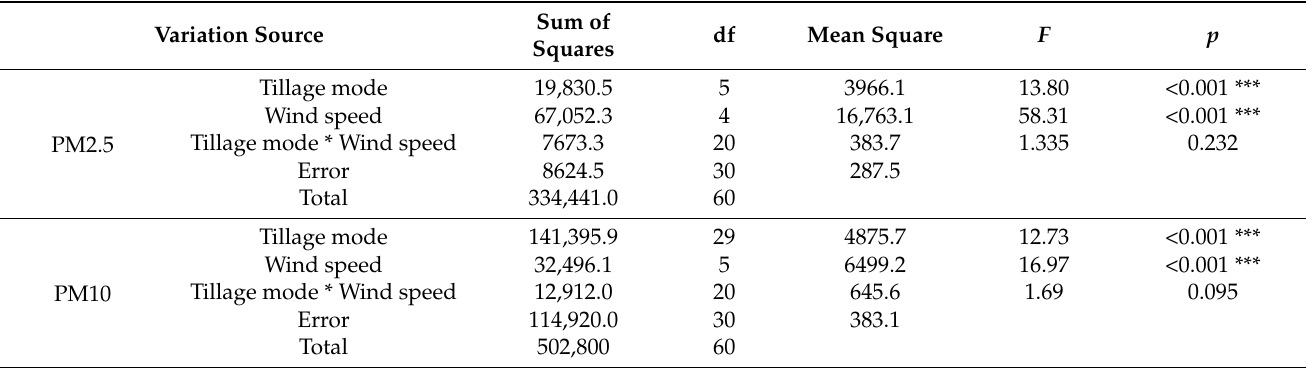
Table 4. Two factor variance analysis of PM2.5 and PM10 release under different tillage mode and wind